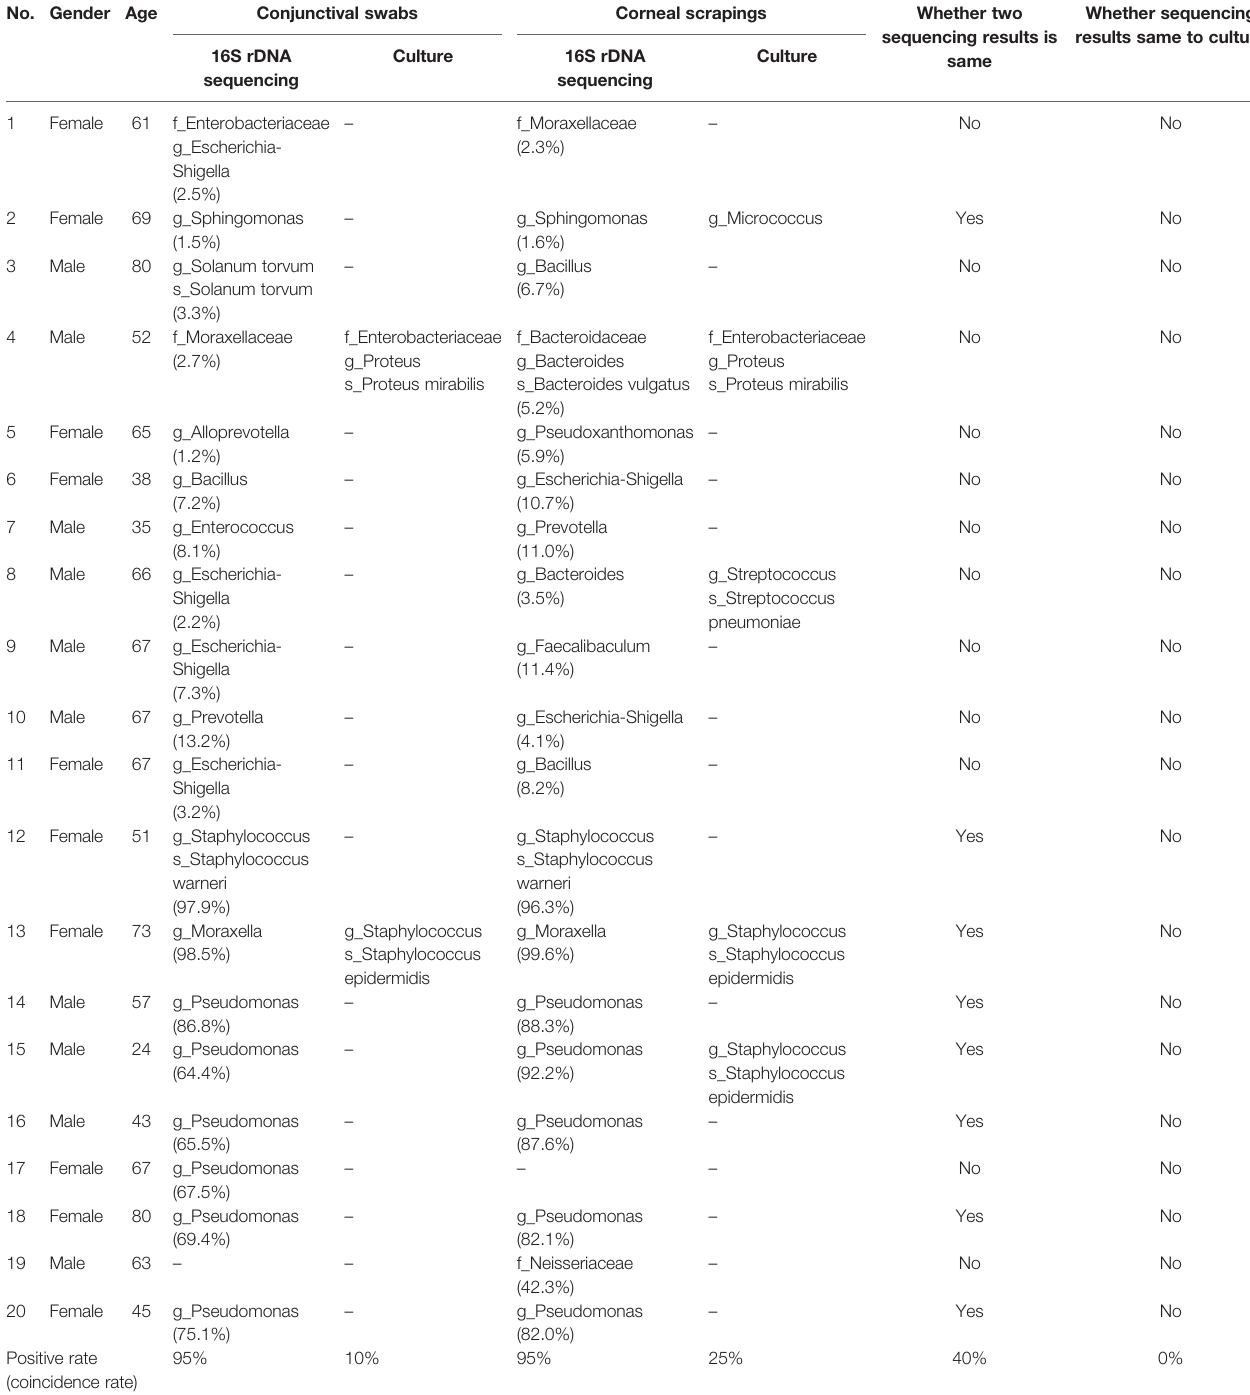
TABLE 1 | The diagnostic information of high-throughput 16S rDNA sequencing and bacterial